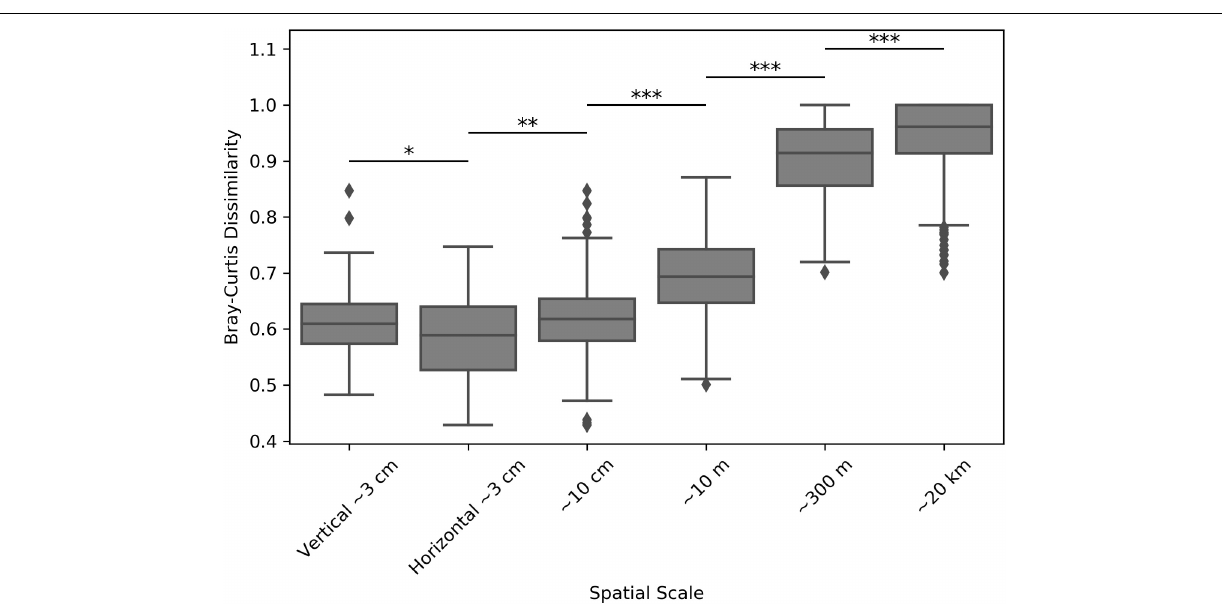
FIGURE 6 | Bray-Curtis dissimilarity between microbial communities in halite samples from different sites, compared across distance scales: ∼ 3 cm (samples from the same nodule and position along the horizontal or vertical component), ∼ 10 cm (samples from the same nodule at any internal position), ∼ 10 m (samples from different nodules at North-top), ∼ 300 m (North-top vs. North-bottom), and ∼ 20 km (North vs. South ends of the salar). Boxplots contain the dissimilarity between all possible inter-sample comparisons in the considered sample groups. Stars denote the p -values of pairwise Student’s T -tests: ∗ p < 0.05, ∗∗ p < 0.01, ∗∗∗ p <